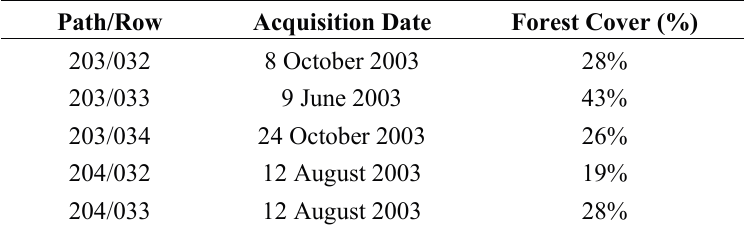
Figure 1. Optical and SAR datasets acquired during the year 2003 and used for this study: ( a ) Landsat-5 TM images shown as false color composite mosaic (R-G-B: 5-4-3); ( b ) ENVISAT ASAR data frames overlaid on the Corine Land Cover (CLC2006) map. Lists of optical and SAR scenes are given in Tables 1 and 2. Table 1. The Path/Row, date of acquisition and percentage of forestland cover (according to the CLC2006 map) for each frame of the Landsat-5 TM data set. The locations of the TM frames are visualized in Figure